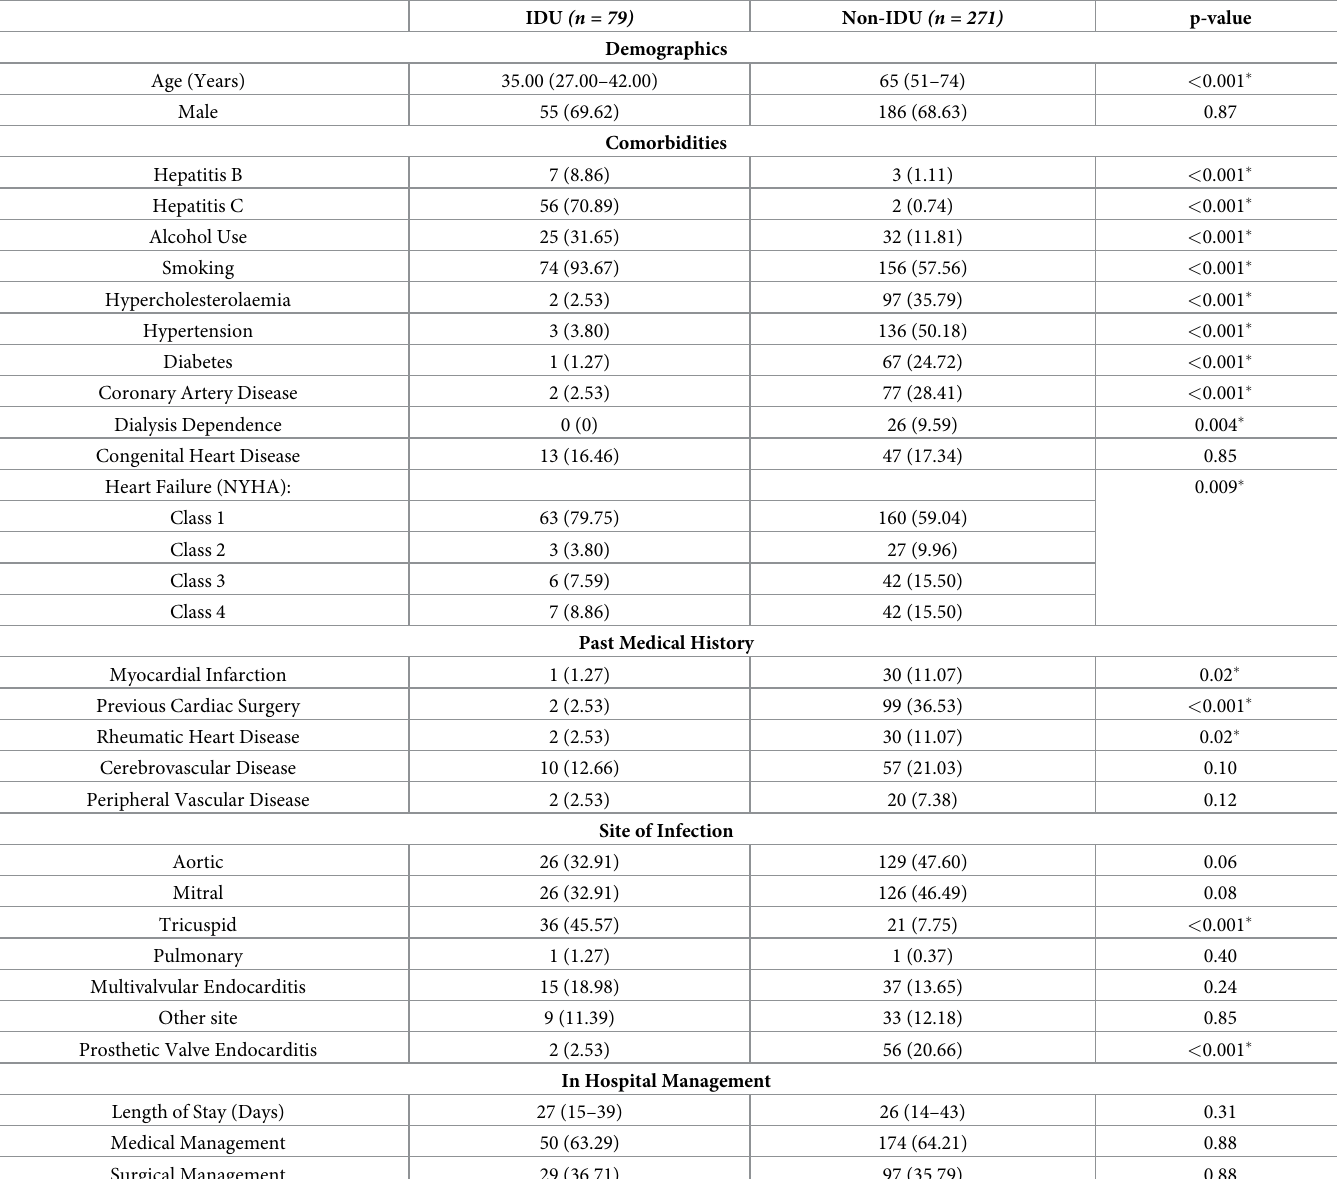
Table 1. Patient characteristics. All categorical data is displayed as total number with percentage proportion in brackets. Continuous data is displayed as median with IQR in brackets. Statistical significance was determined using unpaired t-test for continuous variable, chi-square test for categorical variables with a sample size over five, and Fisher’s exact test for categorical variables with a sample size equal to or less than